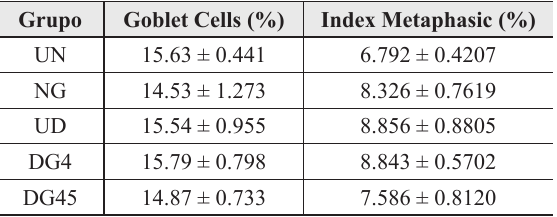
Frequency of Goblet cells and metaphasic indexes of crypts of the ileum of rats belonging to groups in non-treated normoglycaemic rats (UN), L-glutamine-treated normoglycaemic (NG), non- treated diabetic (UD), L-glutamine-treated diabetic (DG4) and (DG45). All results were shown as means ± standard error. n = 5 rats per group.